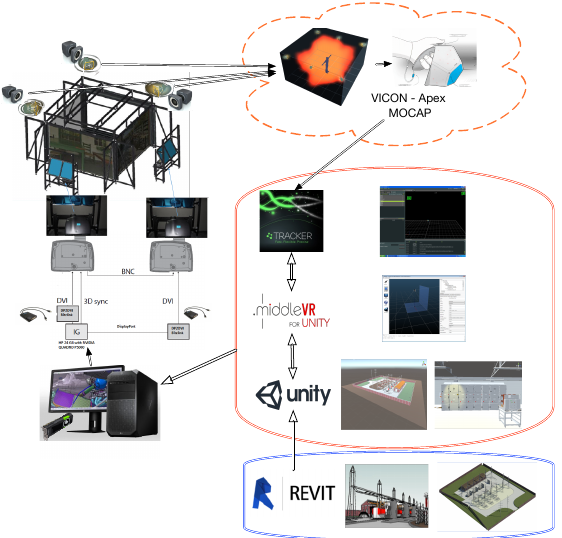
Figure 4. System developed for the simulator. Several hardware systems (CAVE, MOCAP and 6DOF joystick) were integrated with specific software to control and play the simulator. Such software run the game engine and integrated the imported BIM file and MOCAP data to develop